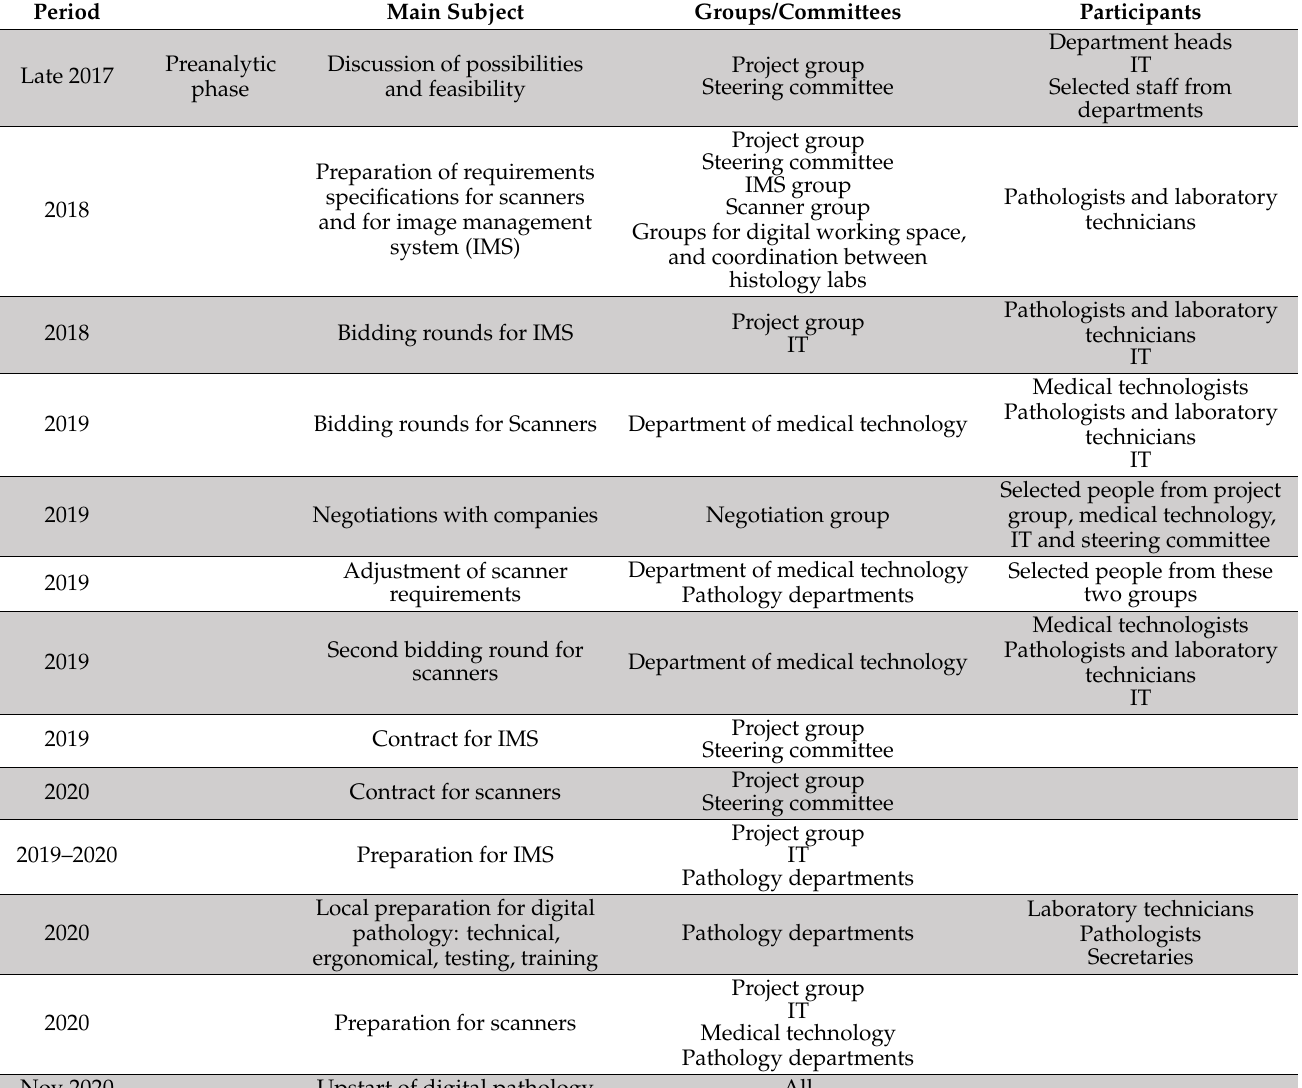
Table 1. A brief step by step overview of the whole implementation process, from the first acceptance of the idea of implementing DIPA in the Region of Southern Denmark to